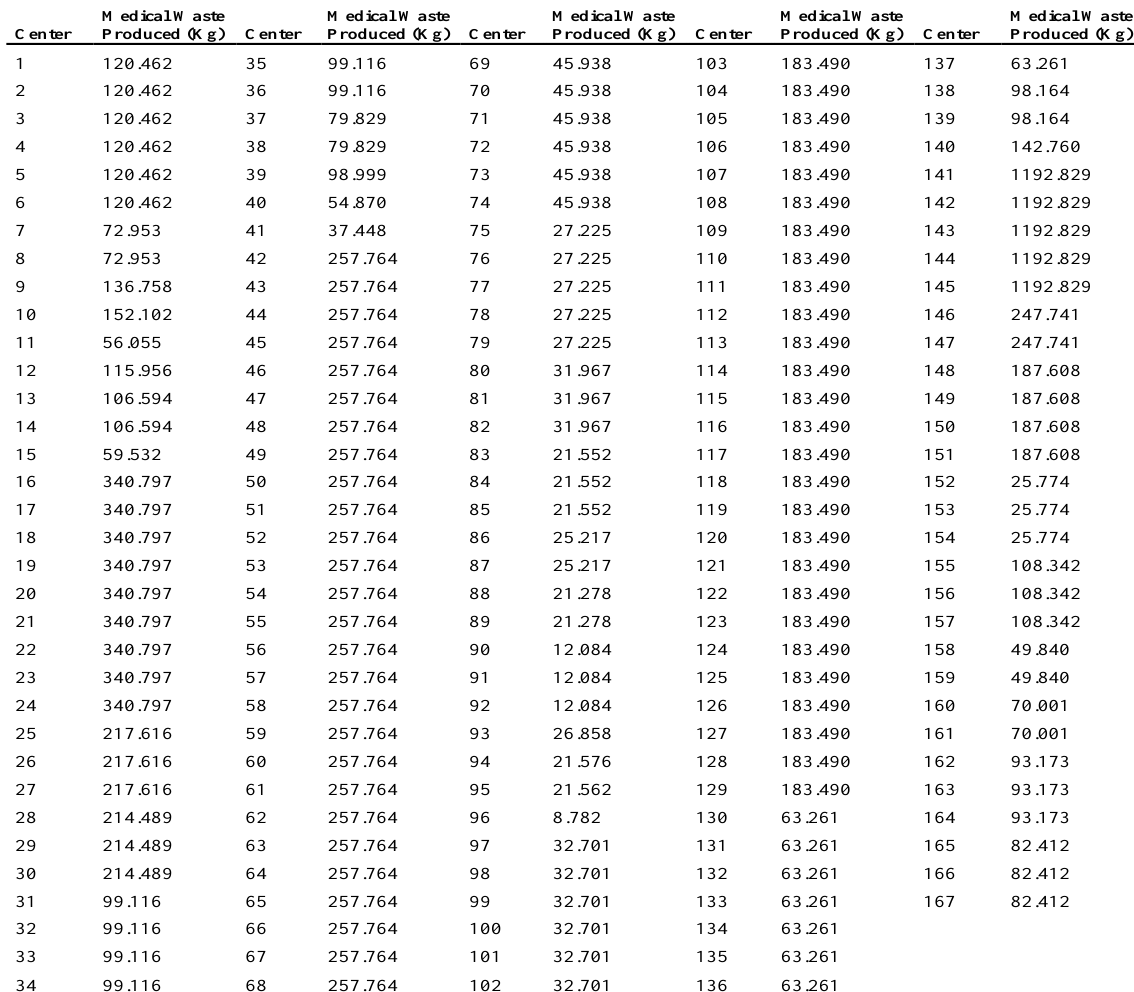
Table1 : Weekly produced medical waste according to the population of each collection